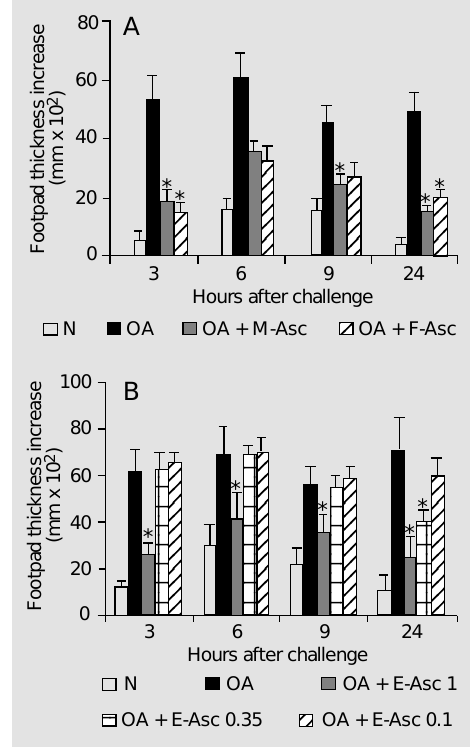
Figure 1. Hypersensitivity reac- tions in mice immunized with ovalbumin (OA), OA + Ascaris suum female (F-Asc) or male (M- Asc) extract (A), or egg (E-Asc) extract (B) at different protein doses (1, 0.35 and 0.1 mg). The mice were challenged 8 days later with aggregated OA in the footpad. Nonimmunized mice (N) were also challenged in the same way for nonspecific swell- ing. The results represent the mean ± SEM for 5-7 animals/ group. *P<0.05 compared with the OA-immunized group (Tukey test).